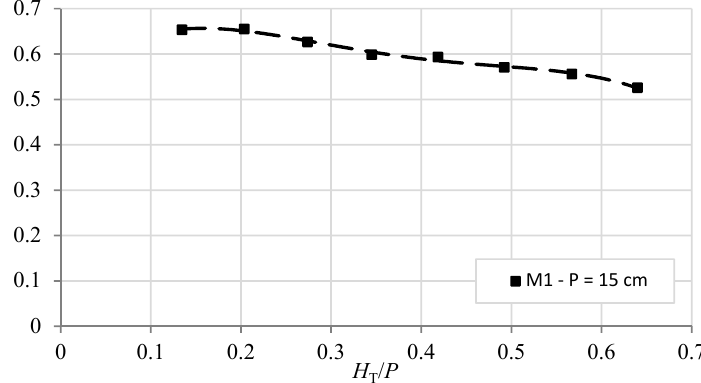
Figure 5. Variations in the discharge coefficient, C L , as a function of the H T /P ratio for the M1 model.